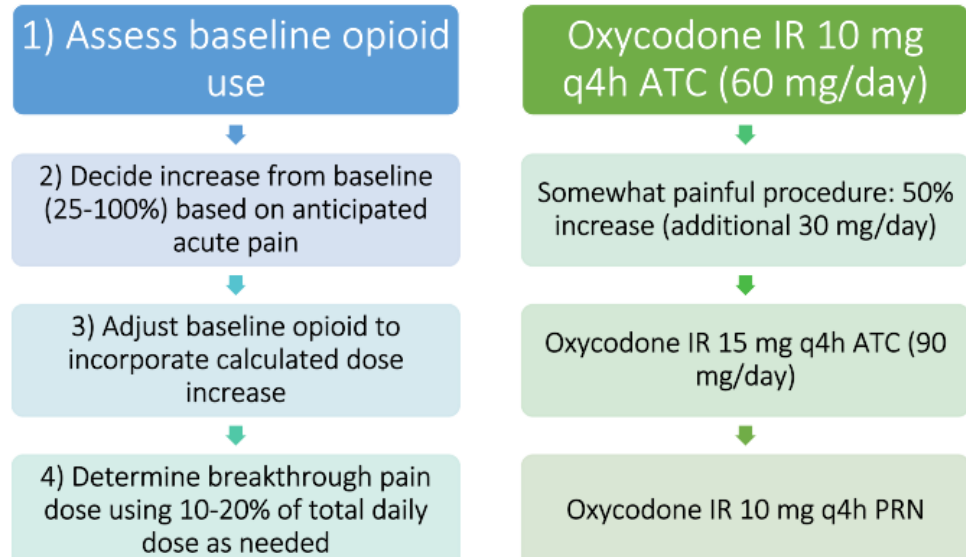
Figure 6. One process and a worked example for constructing an acute pain regimen in a patient with preexisting around-the-clock opioid therapy and tolerance. Legend: At left is a step-wise description of the recommended process, with a worked example paralleled at right. Note- this is one example and will not be ideal for all patients. ATC= around the clock, h = hours, IR = immediate release, q = every, PRN = as needed.